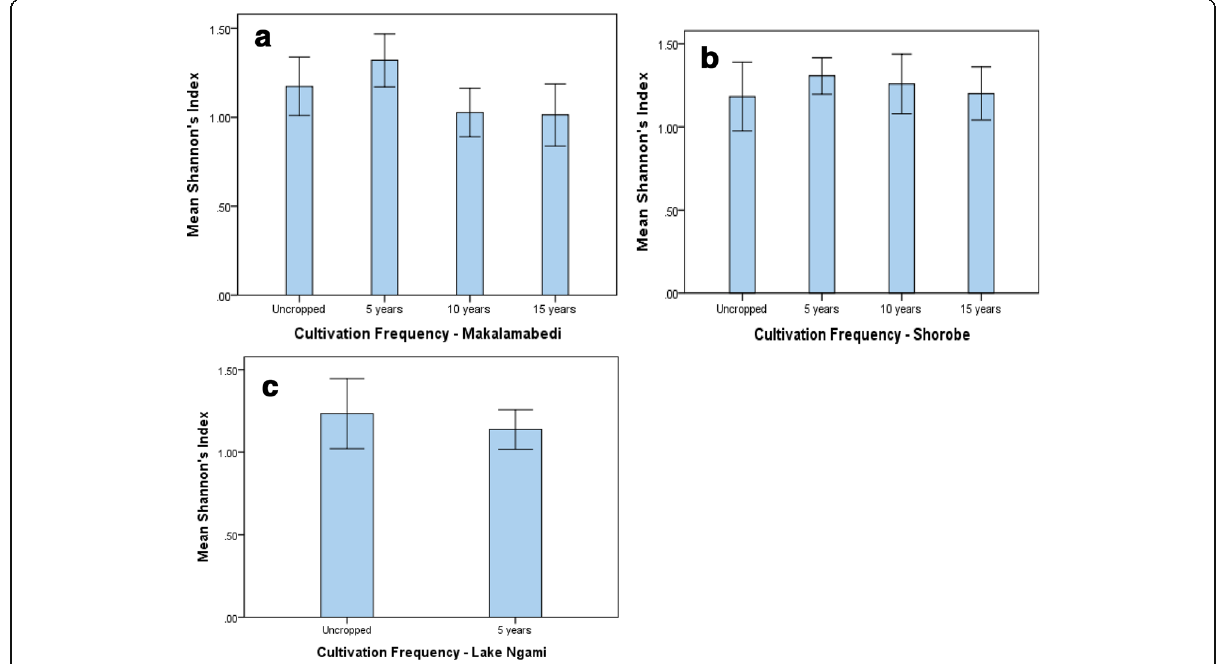
Fig. 5 Influence of cultivation frequency on species diversity within the study sites ( a Makalamabedi, b Shorobe, c Lake